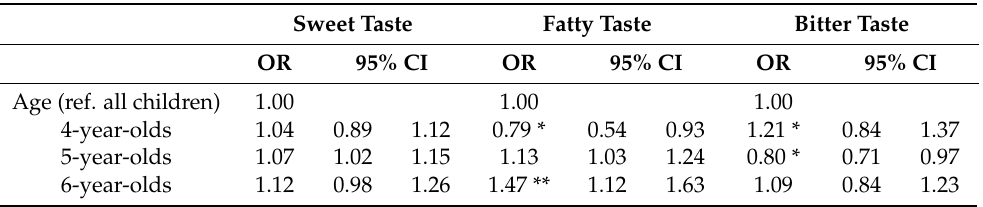
Table 3. Odds ratio (95% confidence interval). The association between age and taste preferences of preschool